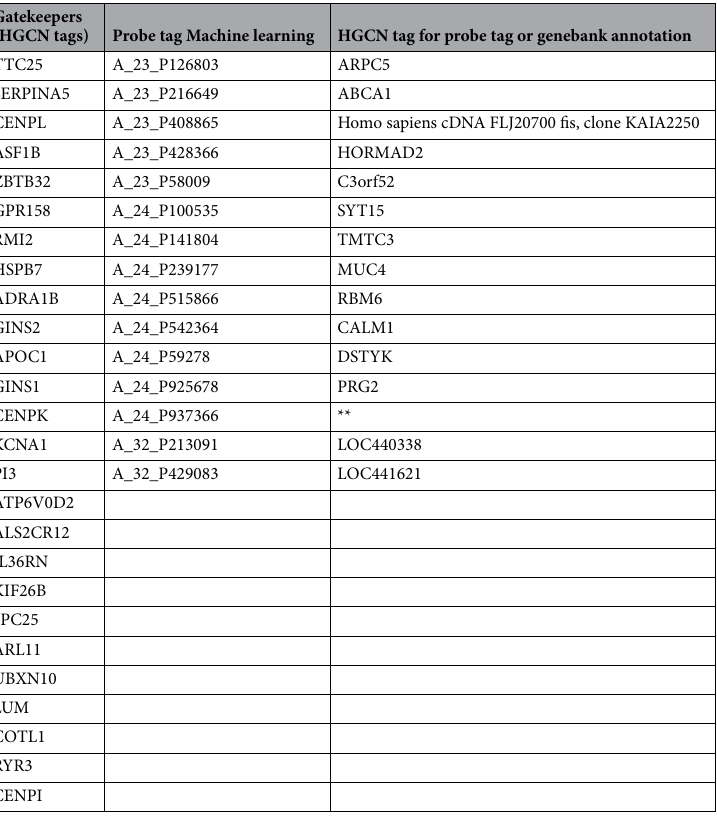
Table 1. Gene list from network gatekeepers and machine learning algorithm. Some Id are labeled as ** which means is a Missing Id. The first column corresponds to Gatekeepers list with 26 genes and the second column to the probe tag id in the microarray chip for 15 genes found with the machine learning method. The third column are the HGCN tags for each probe id of the second column. Second and third columns list finished when blank fields were